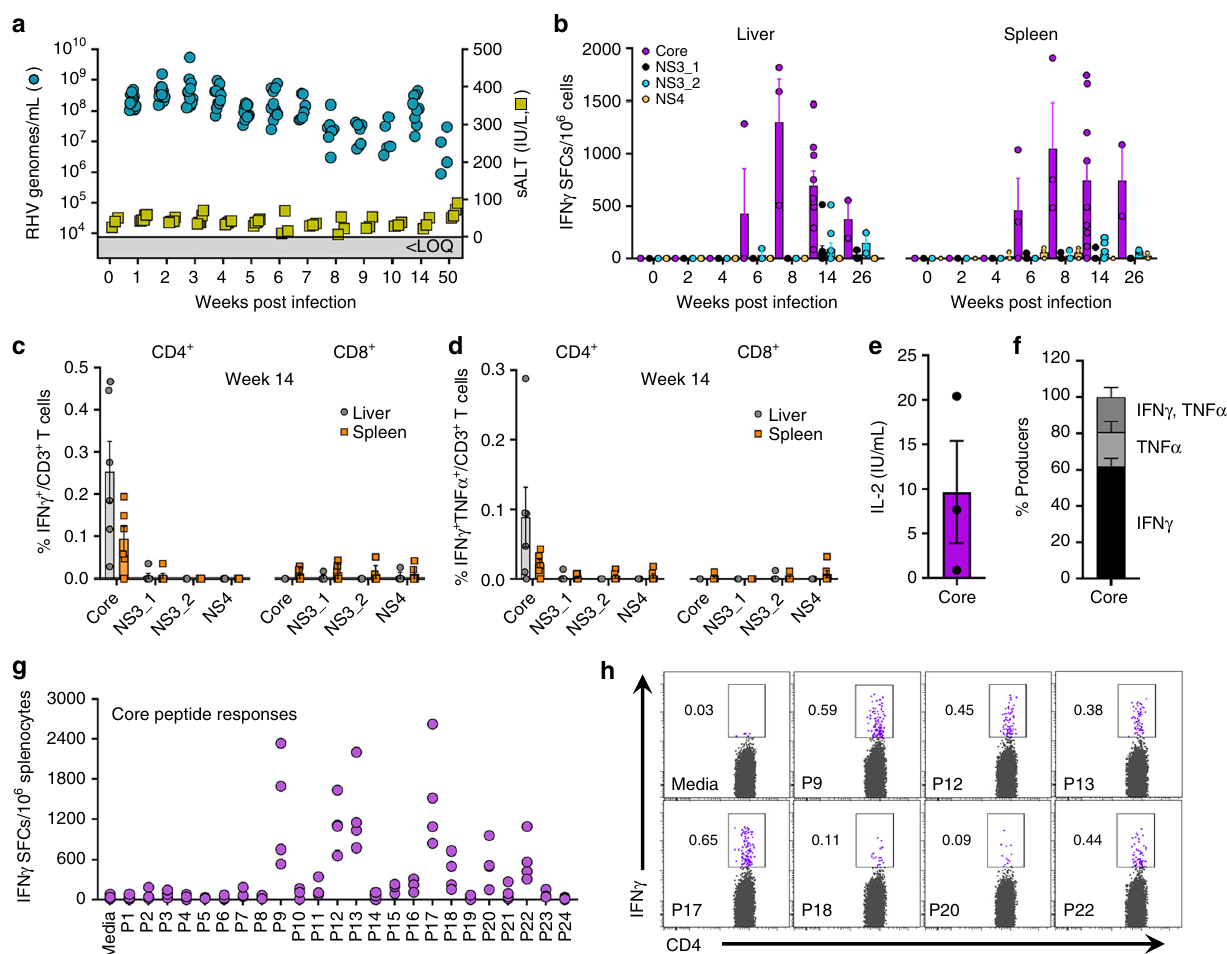
Fig. 1 RHV infection is associated with a limited virus-speci fi c T cell response. Lewis rats were challenged intravenously with 10 6 genomes of RHV and analyzed for infection, pathology, and cellular immunity. a Viremia (blue circles) and serum ALT (sALT, yellow squares) levels after challenge. Solid line with shading below indicates limit of quanti fi cation (LOQ) of RT-PCR. b IFN γ ELISpot responses in livers (left panel) and spleens (right panel) of rats at various time points post infection. Mononuclear cells were stimulated with viral peptides (2 µ g/mL) for 40 – 48 h. Data from n = 2 – 9 rats per time point are shown (mean±SEM). c , d Frequencies of IFN γ + and IFN γ + TNF α + T cells in livers (gray circles) and spleens (orange squares) after 5-h peptide stimulation (2 µ g/mL). Rats were infected for 14 weeks prior to analysis. Left and right panels show frequencies in CD4 + and CD8 + T cells, respectively. Data from n = 6 rats are shown (mean±SEM). e Core peptide-speci fi c IL-2 secretion by CD4 + splenocytes. Cells were stimulated with core peptides (2 µ g/mL) for 48-h prior to supernatant collection. Rats were infected for 14 weeks prior to analysis. Responses from n = 3 rats are shown (mean±SEM). f Relative frequency of intrahepatic CD4 + T cells producing IFN γ , TNF α , or both after 5-h stimulation with core peptides (2 µ g/mL). Data from n = 6 rats are shown (mean±SEM). g Splenic IFN γ ELISpot responses against 24 individual core peptides (10 µ g/mL). Responses from n = 4 rats at >6 weeks infection are shown. h Flow cytometric analysis of IFN γ production by CD4 + T cells following 5-h stimulation with core-derived MHC class II epitopes (10 µ